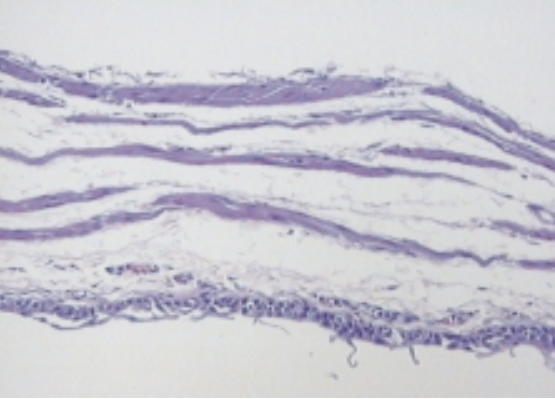
FIGURA 5 - Edema acentuado da parede vesical. (HE x